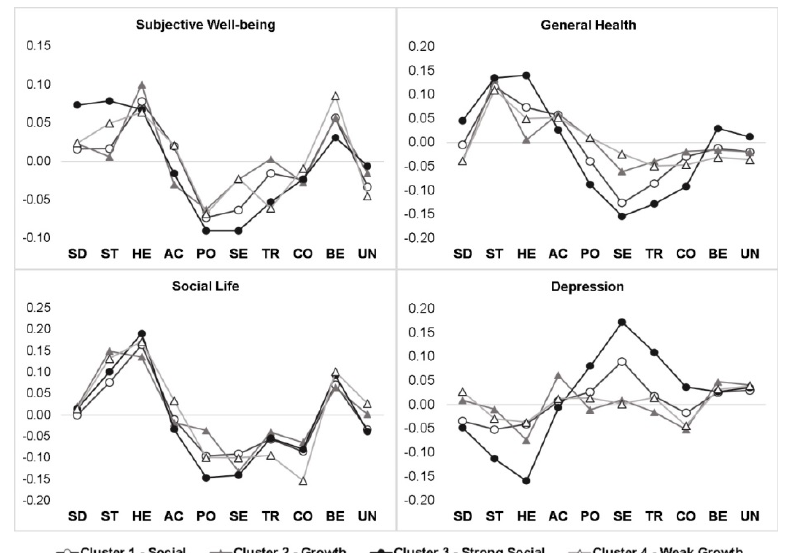
Figure 6. Graphical representation of Spearman correlations between value priorities and the indicators of SWB, SGH, social life, and depression of the four clusters. (SD—self-direction; ST—stimulation; HE—hedonism; AC—achievement; PO—power; SE—security; TR—tradition; CO—conformity; BE—benevolence; UN—universalism).